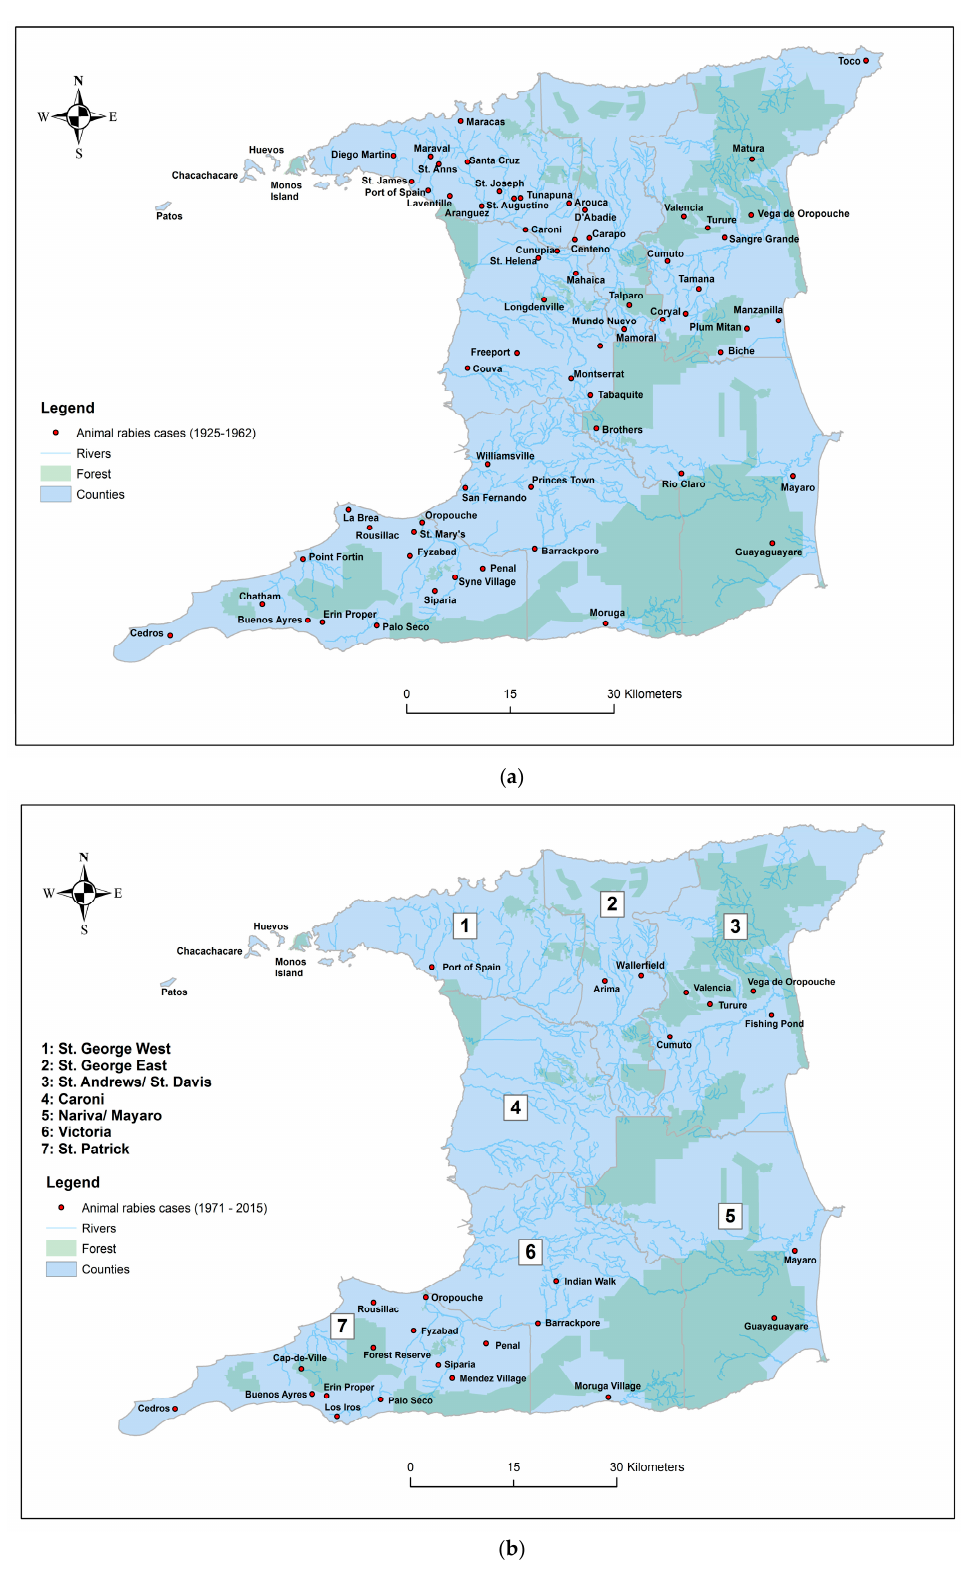
Figure 3. Geographic locations from which animal rabies cases were reported in Trinidad during the periods ( a ) 1925–1962 and ( b ) 1971–2015.